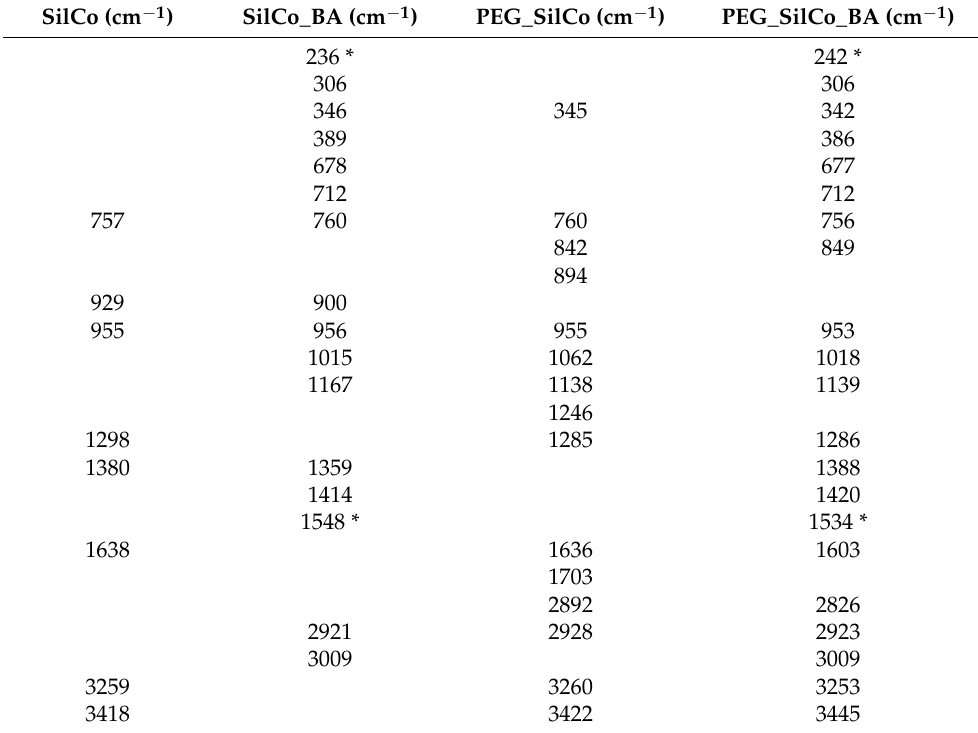
Figure 3. Raman spectra of ( a ) the silver nanocolloids loaded with betulinic acid and ( b ) the PEGylated silver nanocolloids loaded with betulinic acid. The spectra were acquired using 20 s scans and were averaged over 3 cycles. Table 2. Silver nanocolloids and PEGylated silver nanocolloids empty and loaded with betulinic acid together with their tentative Raman mode assignments (533 nm).